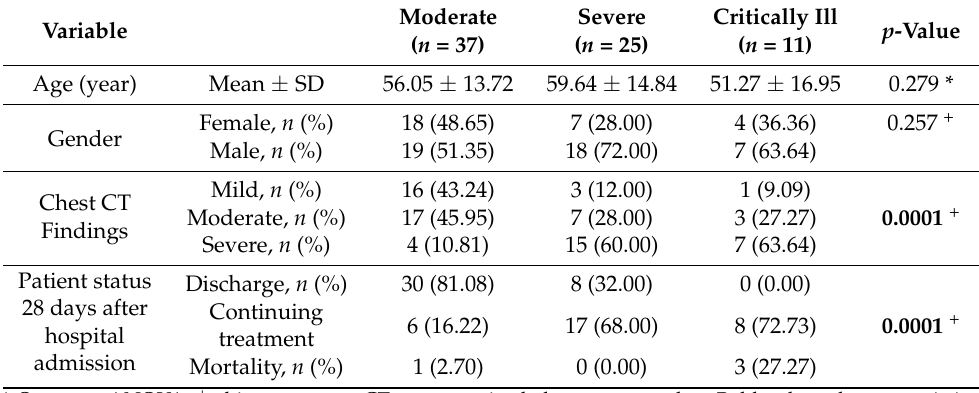
Table 1. Characteristics of patients according to the severity of COVID-19 pneumonia (classified as moderate, severe, critically ill).